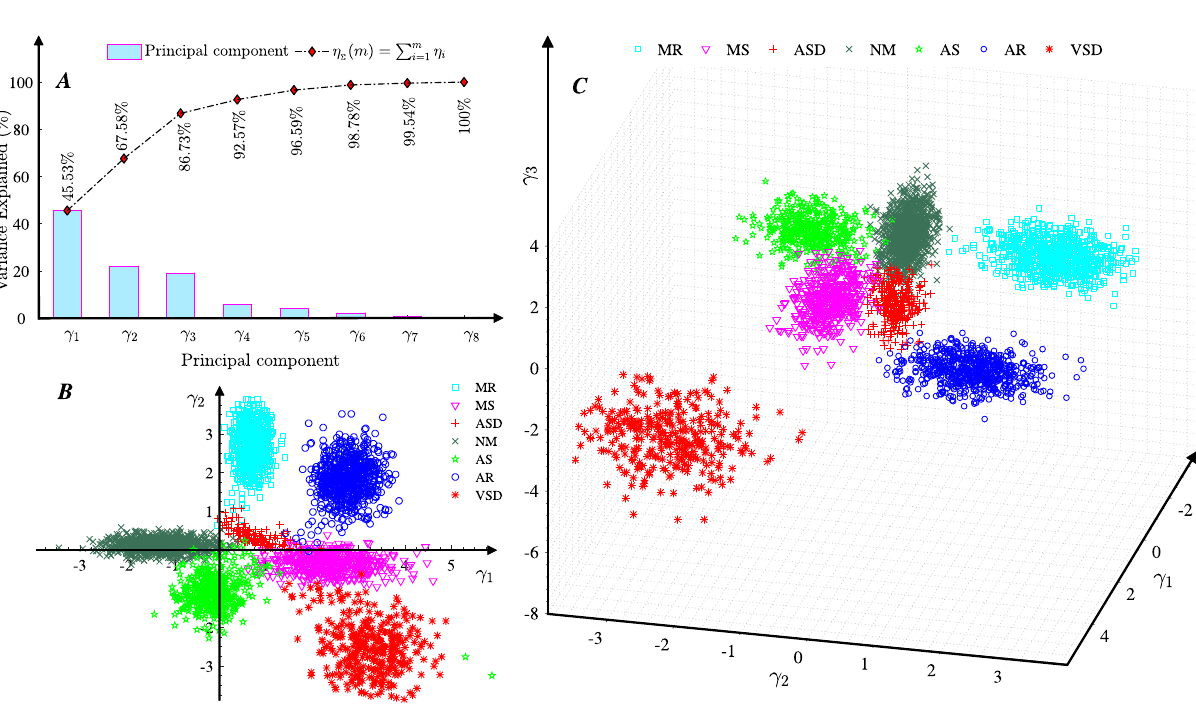
Figure 7. PCA results. A shows the Pareto chart of the variance by contribution of each principal component, B plots the scatter diagram of the first two components γ 1 and γ 2 , and C shows the first three components γ 1 , γ 2 and γ 3 .